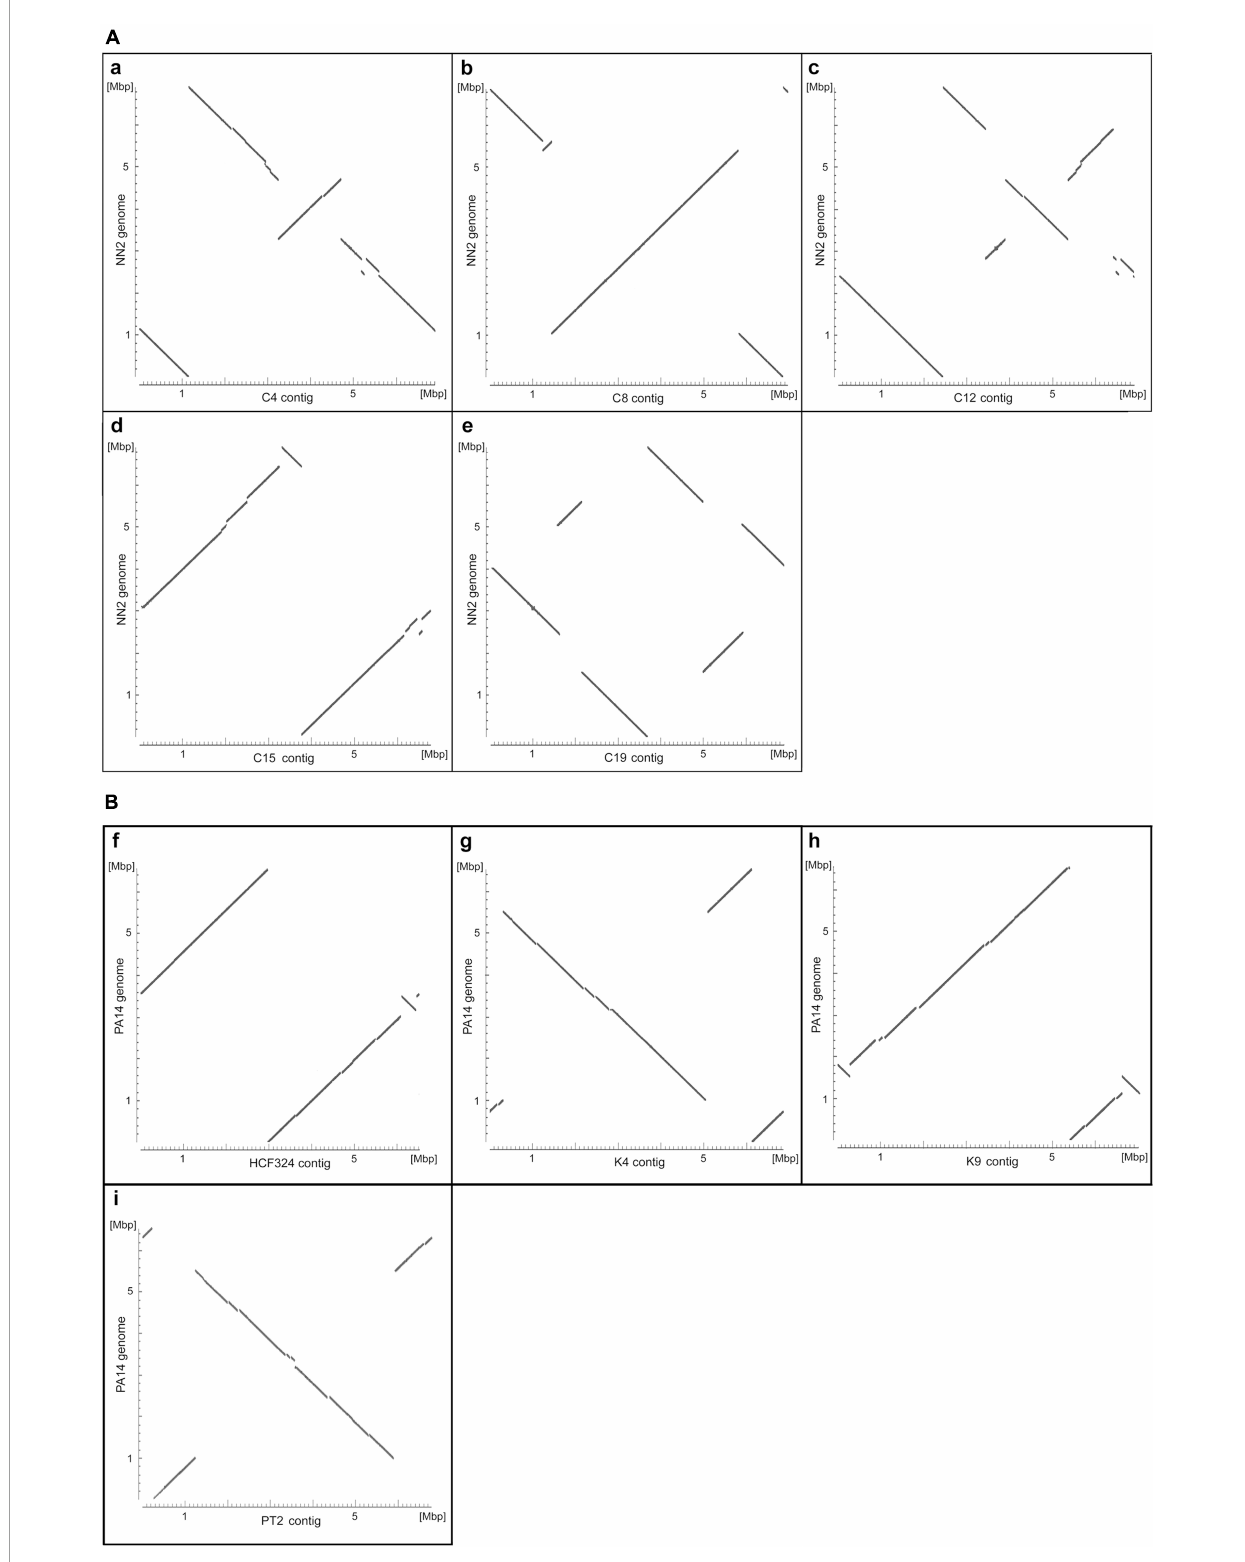
FIGURE1 Alignment plots of clone C (A) and clone PA14 (B) genome assemblies. The plots display the highly similar sections of the assembled genome contigs of the clone C strains C4 (a), C8 (b), C12 (c), C15 (d), and C19 (e) and the strain NN2 sequence (NZ_LT883143.1) and of the clone PA14 isolates HCF324 (f), K4 (g), K9 (h), and PT2 (i) and the strain PA14 sequence (NC_008463.1). Sequence similarities were determined by pairwise blastn alignments of an assembled contig and the reference and appear as diagonal lines in the plots. Changes in the orientation of diagonal line segments indicate inverted DNA sections. Please note that, in contrast to the reference sequences, the sequence contigs of the other strains were not adjusted to start at the oriC region and could represent either the forward or the reverse DNA strand. Consequently, conserved regions between a contig and the reference sequence do not necessarily appear as diagonals starting at the bottom left corner of the